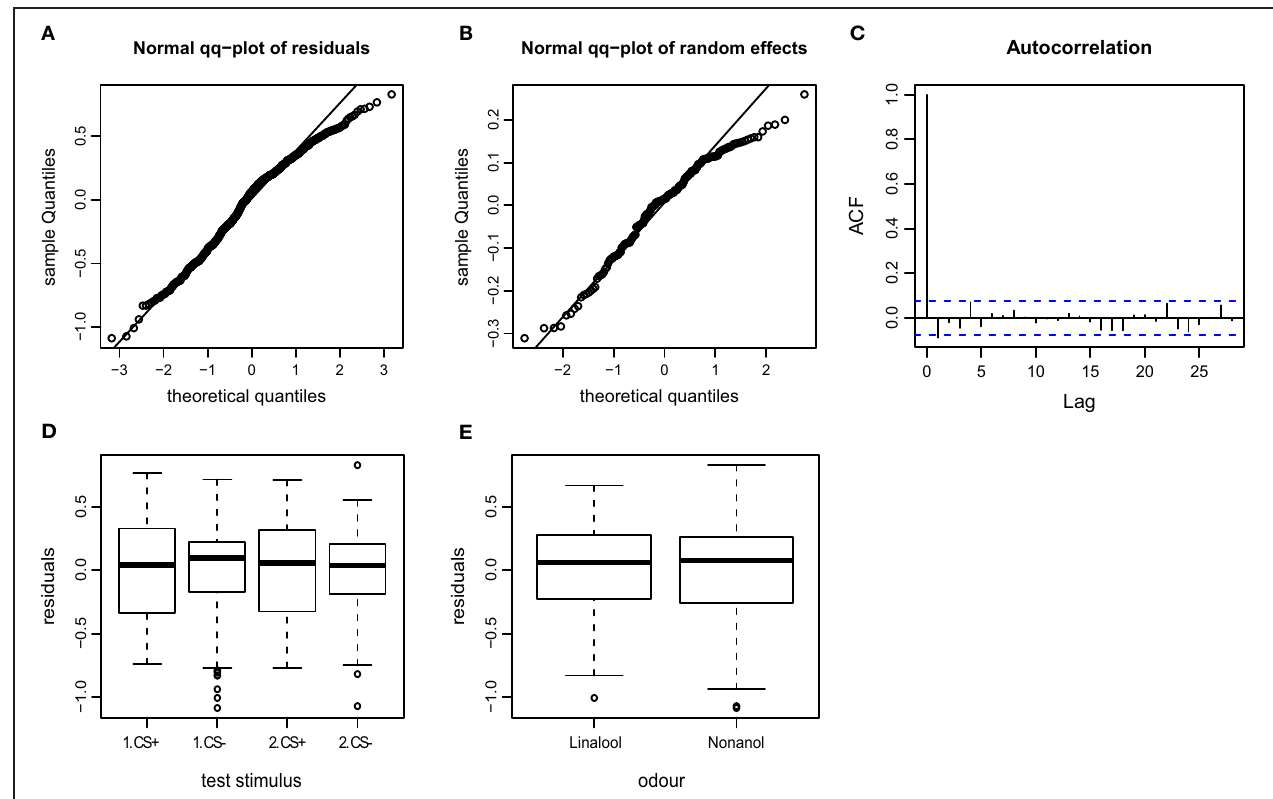
correlation to the previous residual. Less than 5% of the correlation coefficients reach the significance levels (indicated by the broken blue lines), and no systematic pattern is evident. Thus no auto-correlation can be observed in the fitted data. (D) Boxplot of residuals of the AI for the test trials indicates that the residuals within each testing group are symmetrically distributed around the predicted means (which are aligned to y = 0). The residual variation seems to be smaller for the CS − than the CS + test trials, indicating that AI following the odor that was paired with shock during the training phase vary to a greater extent than the AI following non-shock-paired odor. (E) Residuals plotted against the odors used for stimulation. The residuals of the AI vary to similar degrees for both linalool and